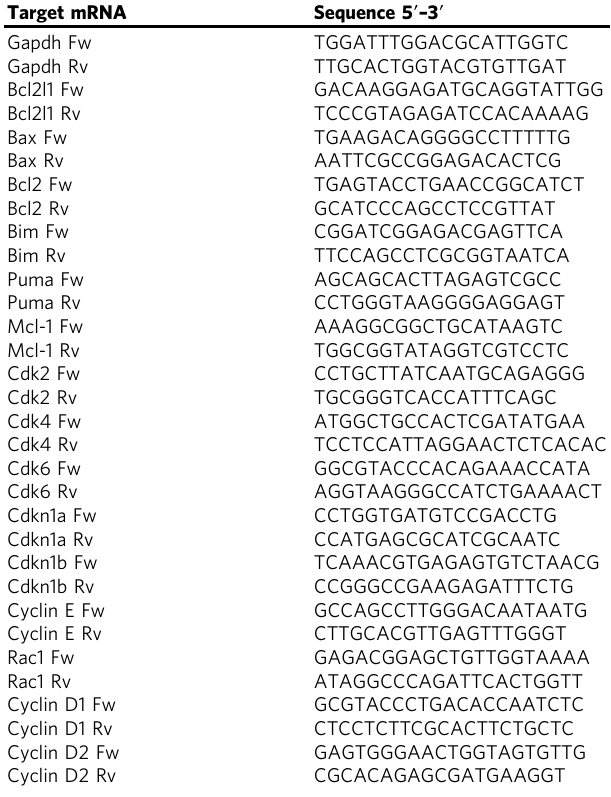
Table 1 Primers used for mouse gene detection Target mRNA Sequence 5 ′ – 3